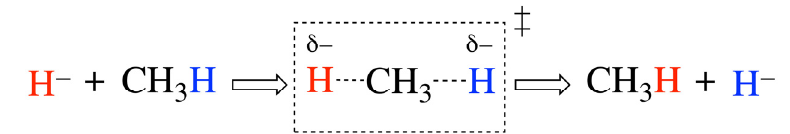
Figure 1. Energy profile for S